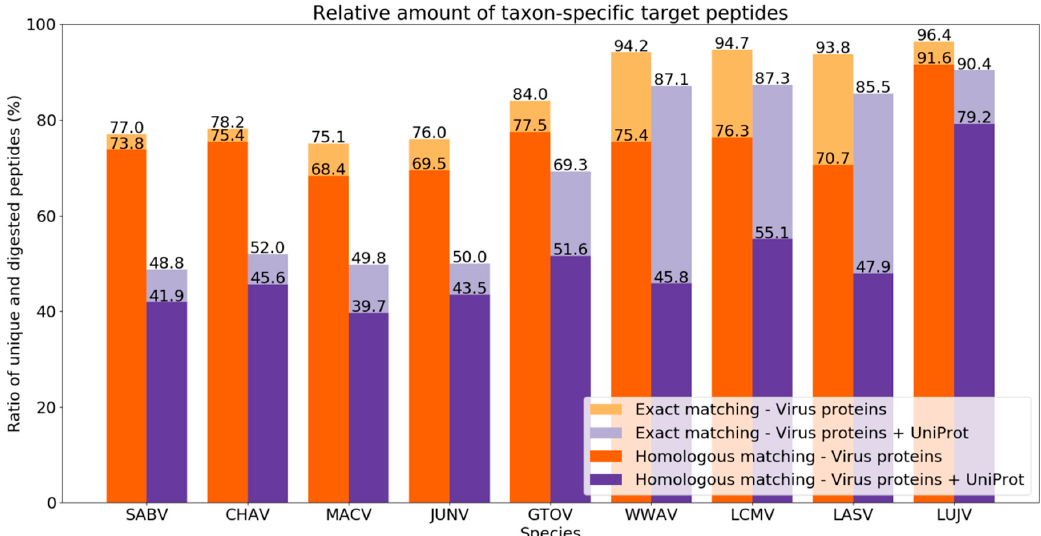
Figure 4. Relative amount of taxon-specific target peptides from nine arenavirus species proteomes. The ratio of unique to in silico-digested peptides is shown for exact (lighter colors) and homologous (darker colors) matching mode with a background consensus threshold of 80%. Orange bars show the results for the database consisting of four virus proteins for each arenavirus species. Purple bars indicate results that were generated when adding protein sequences from all reviewed virus proteomes (from UniProt/Swiss-Prot) as additional background.